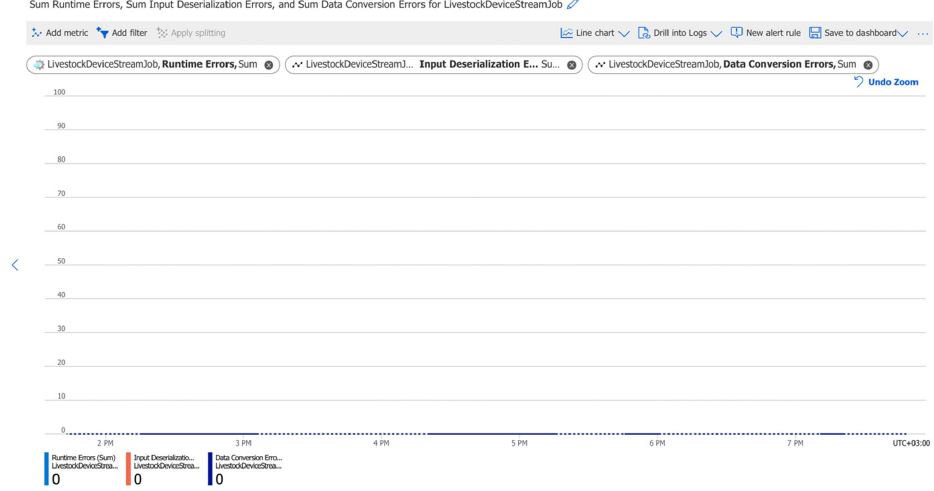
Figure 11. Stream Job sum of errors. The blue line shows the sum of runtime errors. The Red line shows the sum of input errors. The dark blue line shows the sum of data conversion errors. The dotted line shows that no data is ingested for that period (when IoT devices are in sleep mode).